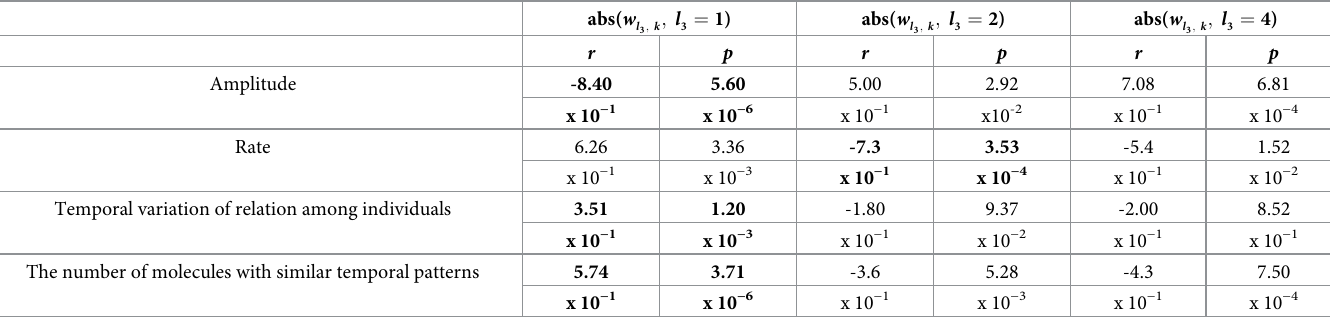
Table 2. Correlation between features of temporal patterns by hypothesis-driven analysis and features of each molecule extracted by data-driven analysis.